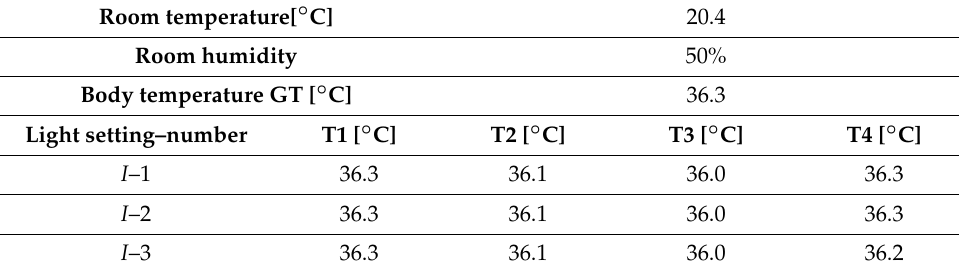
Table A11. Light influence experiment. Subject 2 body temperature